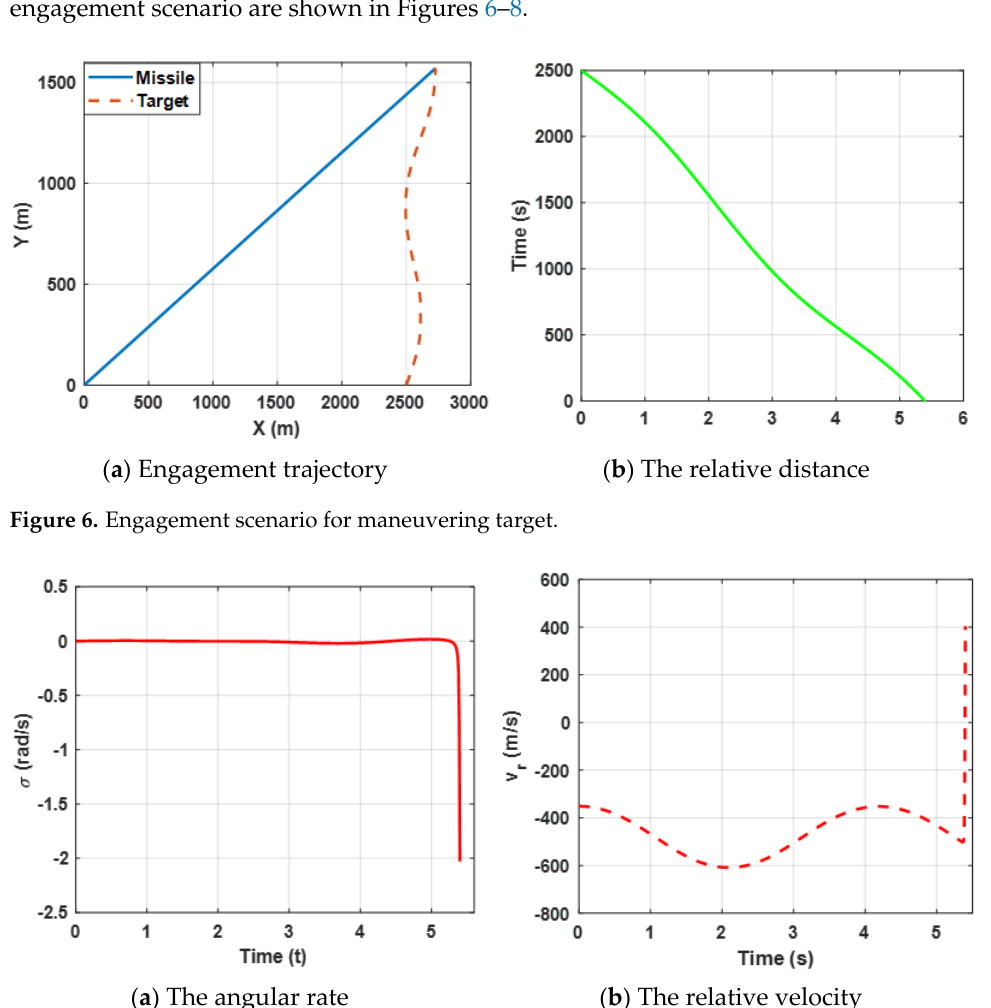
Figure 7. Curves of the angular rate and the relative velocity for a maneuvering target.